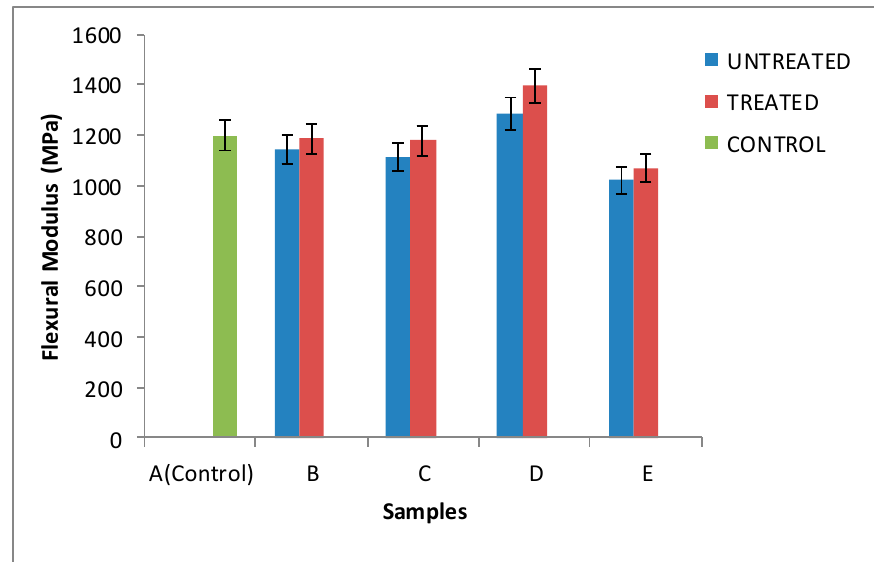
Figure 9. The flexural modulus of the control sample and the developed composites.